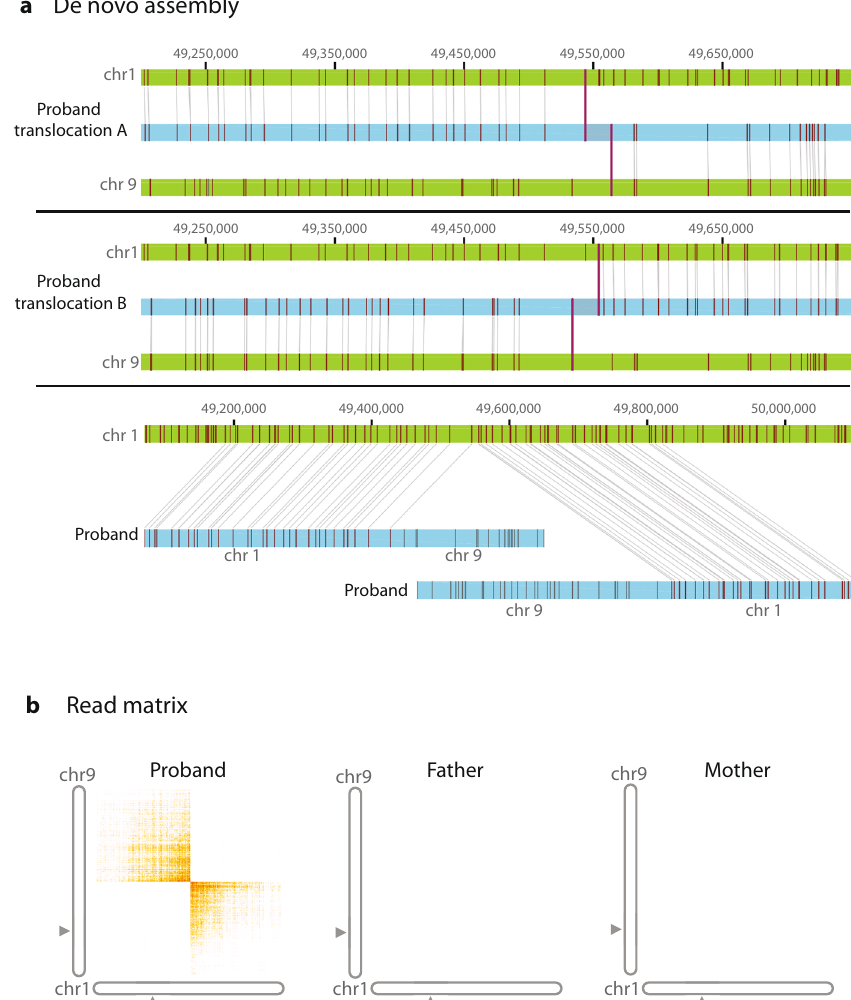
Fig. 2 Structural rearrangement detection with de novo assembly and linked reads; t(1:9)(p33,p21). a Contains de novo assemblies of chromosome 9 and 1. Genomic coordinates in gray at the top and the reference assembly in green (reference GRCh38). The proband assembly map is shown in blue with vertical maroon lines that show matching label patterns. The fi rst and second panels show two de novo assembly maps that align to reference chromosomes 1 and 9 and the translocation breakpoint where the alignment switches. The third panel depicts two assembly maps in chromosome 1 with segments that align and segments that do not align to the reference due to the translocation. b Shows the matrix view of linked reads that contains unexpected barcode overlap (in orange) between chromosome 1 and 9, corresponding to the intronic point of fusion between the two. This overlap is absent in the